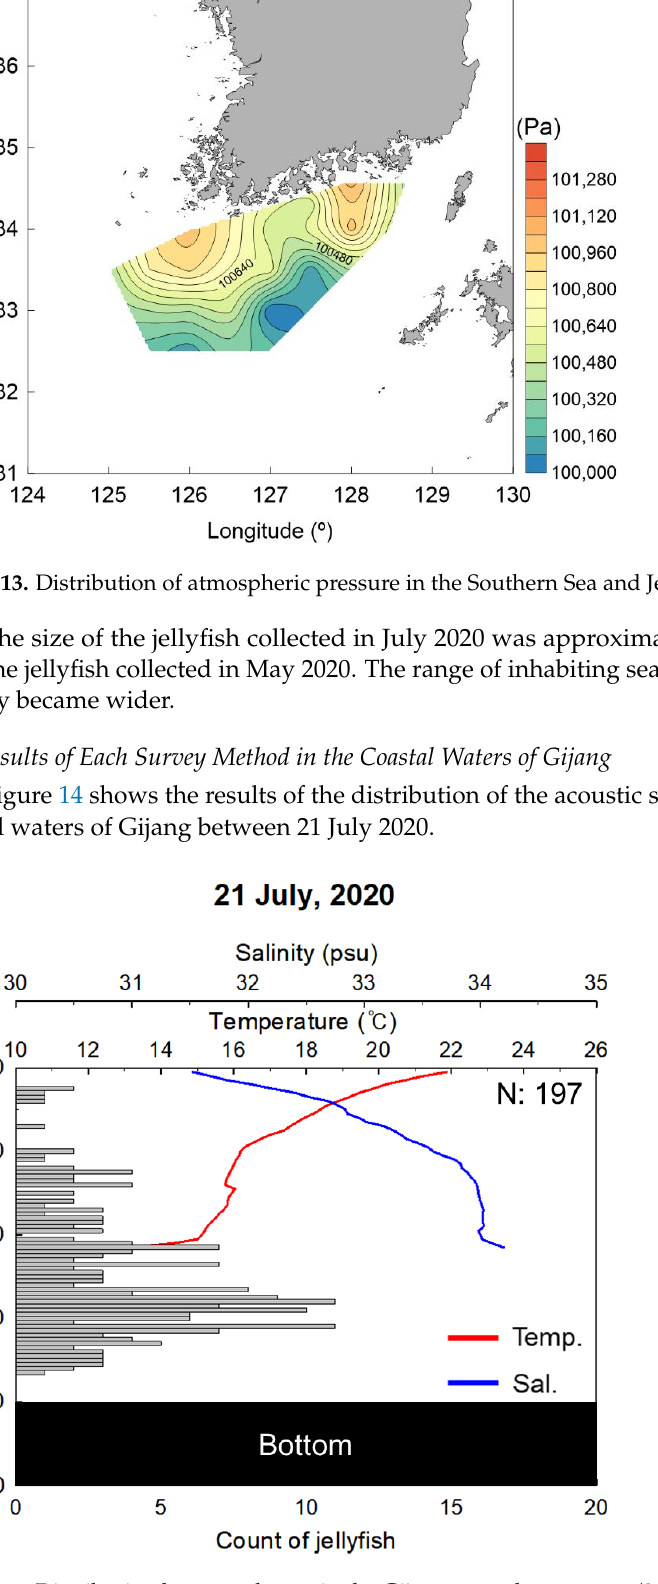
Figure 14. Distribution by water layers in the Gijang coastal waters sea (21 July, 2020). Table 10. Distribution density of jellyfish using the echo counting method in the Gijang coastal wa- ters sea (7/21).